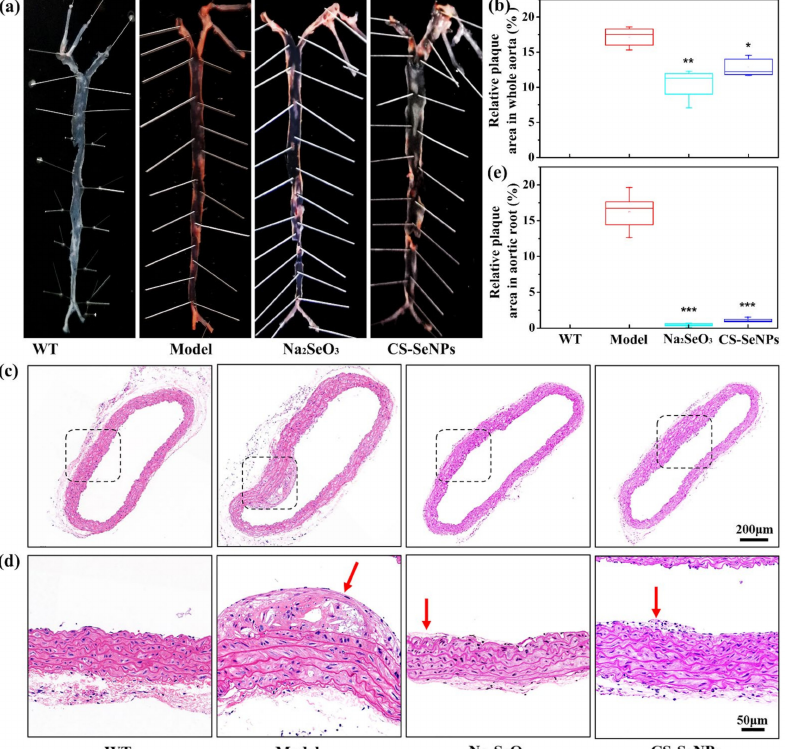
Figure 3. CS-SeNPs and Na 2 SeO 3 reduced atherosclerotic lesions in HFD fed ApoE -/- mice. ( a ) Whole aorta with en face Oil red O-staining. Representative images of Oil red O-stained whole aorta from each group were shown. ( b ) Atherosclerotic lesions were quantified and the values were expressed as percentage of lesion area (Oil red O-positive area) to total surface area of the aorta ( n = 5). * p < 0.05, ** p < 0.01, compared with the AS model group. ( c ) Representative images of HE-stained aortic root cross section from each group (50 × ). ( d ) Magnified views (150 × ) corresponding to the black rectangles in ( c ). Red arrows refer to the atherosclerotic plaque. ( e ) Atherosclerotic lesions in aortic root were quantified and the values were expressed as percentage of lesion area to total surface area of the aortic root ( n = 5). *** p < 0.001, compared with the AS model group.